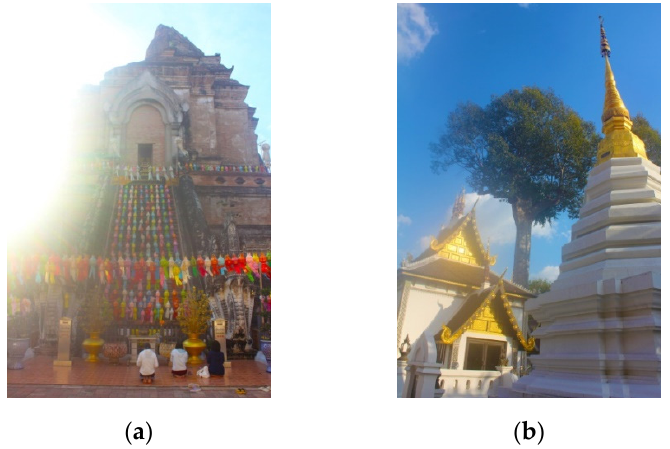
Figure 8. ( a ) The Pagoda of Chedi Luang Temple represented to the cosmological belief of urban planning as “the central of universe” (Author). ( b ) The relationship of City Pillar Shrine and the Spiritual of Ancient Yang Tree (Author).